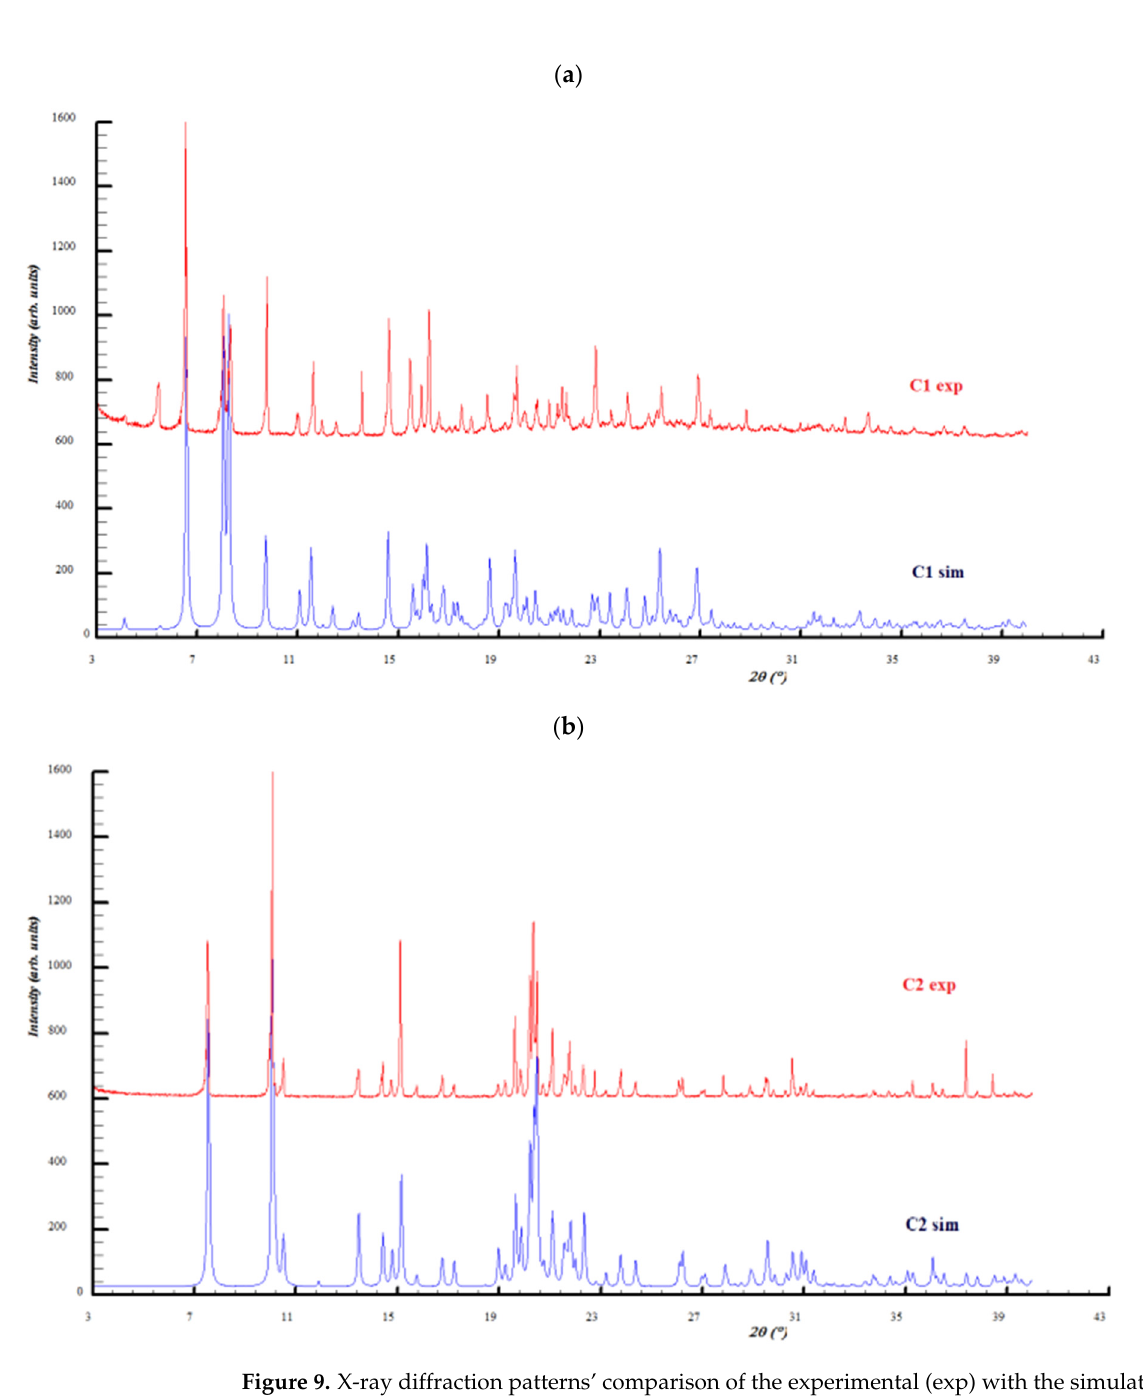
Figure 9. X-ray diffraction patterns’ comparison of the experimental (exp) with the simulated (sim) investigated copper complexes: C1 ( a ) and C2 ( b ).